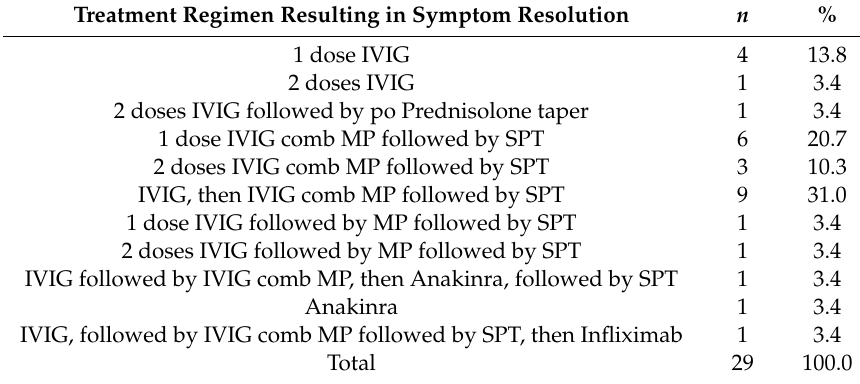
Table 3. Treatment regimens used in this cohort. IVIG—intravenous immunoglobulins, SPT—short Prednisolone taper, MP—Methylprednisolone, FU—follow-up.